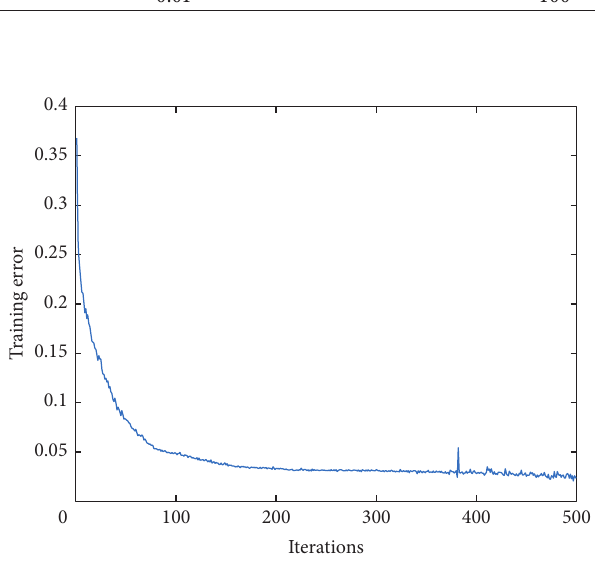
Figure 11: Error variation curve of training